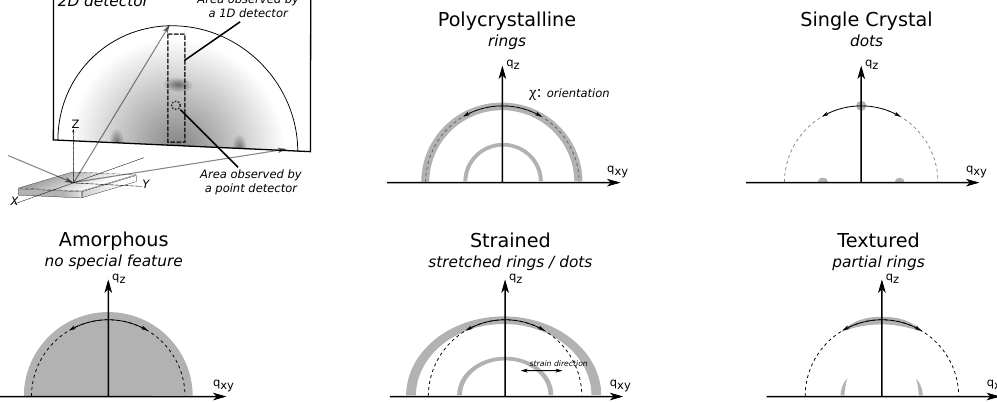
Figure 6. Illustration of XRD with a 2D detector, showing the measurement geometry and illustration of image data from samples with different textures. A 2D detector enables the user to take a “picture” of the diffraction pattern, effectively providing data that are usually obtained from multiple XRD scans using point and 1D detectors at the expense of data resolution. A radial slice of the 2D data provides the usual information on (cid:126) q . On the other hand, the angular slice of the data provides insight on the film texture. For example, data from a polycyrstalline film appears as rings, a single crystal as dots, and an amorphous material as having no special feature. Data from a sample with texture somewhere in-between these extremes will appear as partial rings. Additionally, macro strains on the sample result in shifted dots or stretched rings. Lastly, in grazing incidence geometry, the region close to the origin of the detector is usually covered by beam stops to prevent damage from direct X-ray radiation, leaving a small hole in the data that is not illustrated